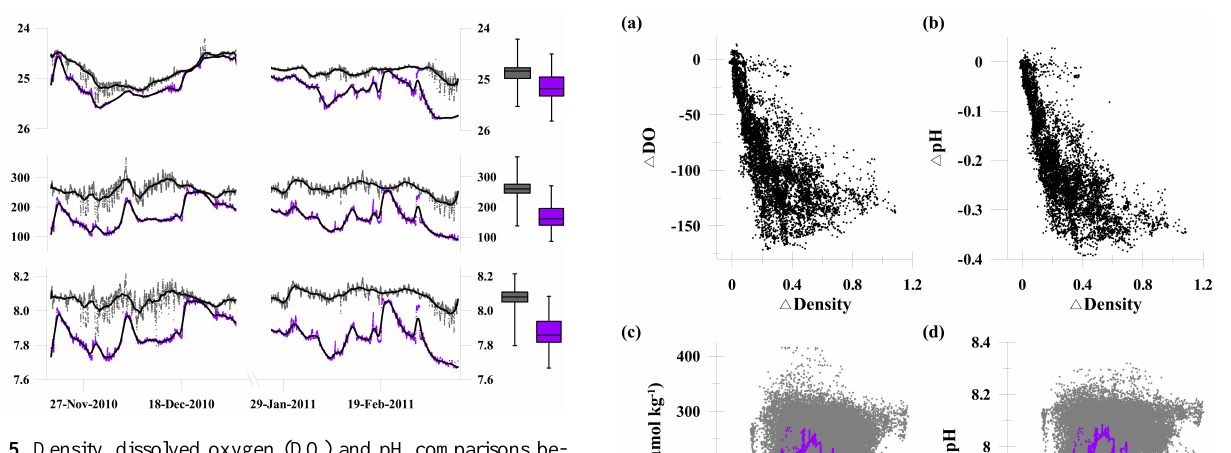
Fig. 5. Density, dissolved oxygen (DO) and pH comparisons be- tween 7m (grey) and 17m (purple) at mooring A during two sep- arate deployments. Time series and corresponding box plots of (a) density, (b) dissolved oxygen and (c) pH. Black solid lines are 2-d smoothed data. Density scale is reversed. Box plots at right depict the minimum, maximum, median, lower quartile and upper quartile for corresponding time-series data.